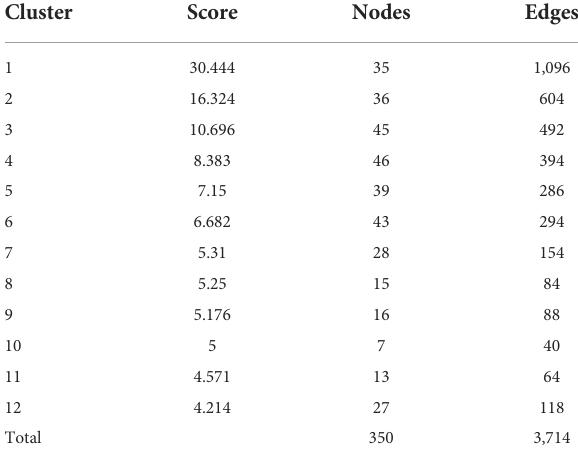
TABLE 2 MCODE cluster of protein – protein interaction of core genes.